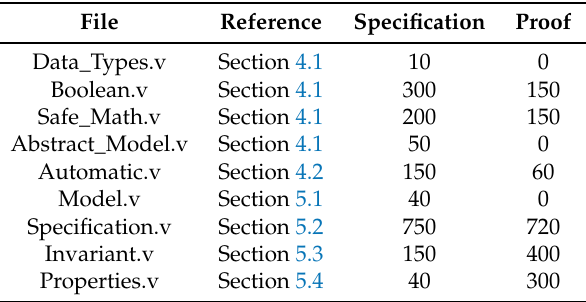
Table 1. Overview of the formal verification of the BNB